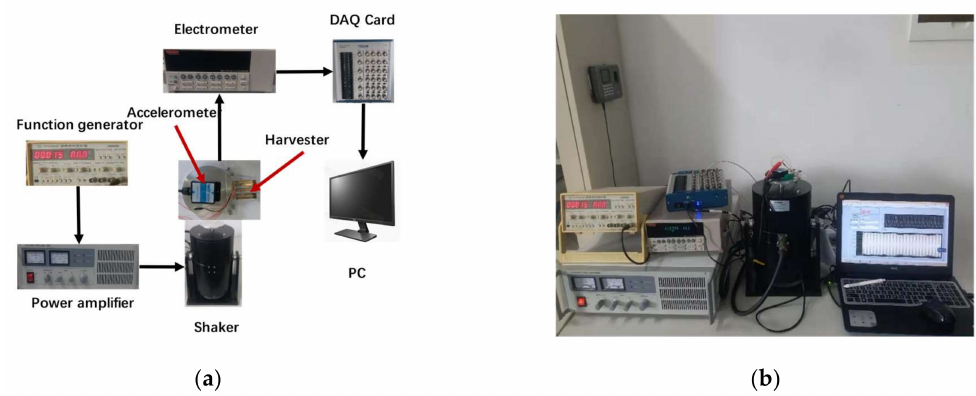
Figure 6. ( a ) Schematic of experimental setup for the PEH testing; ( b ) The experimental scene diagram of the PEH